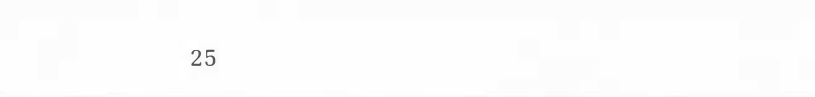
Figure 8 The (steam?] conduit, looking towards the west, showing the line of cap stones that covered